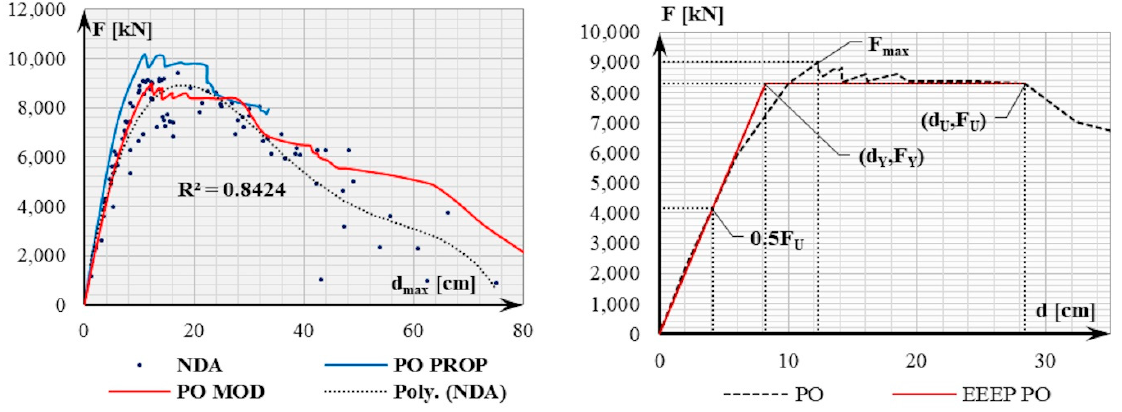
Figure 9. NSA and NDA results ( left ) and pushover curve bilinear approximation ( right ). Displacement (d), IDR and their mean values, obtained using NDA, are displayed in Figure 10.